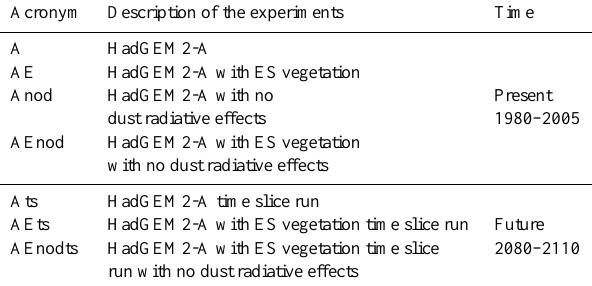
Table 1. List of